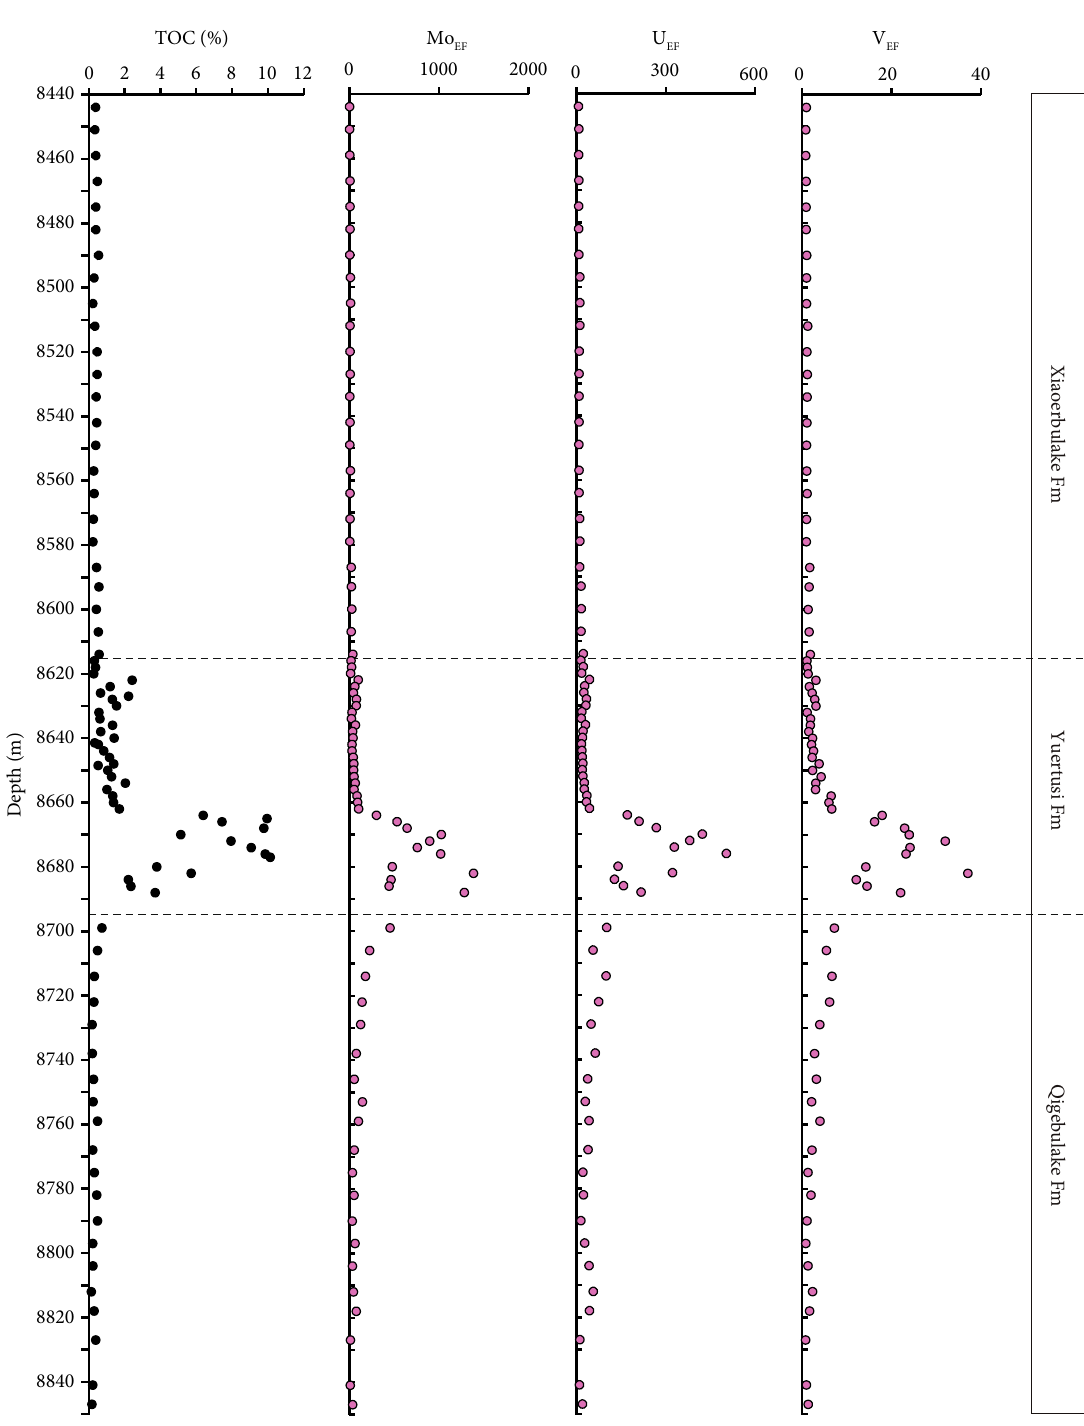
, U , and V in the Sinian-Lower Cambrian in well Luntan EF EF EF